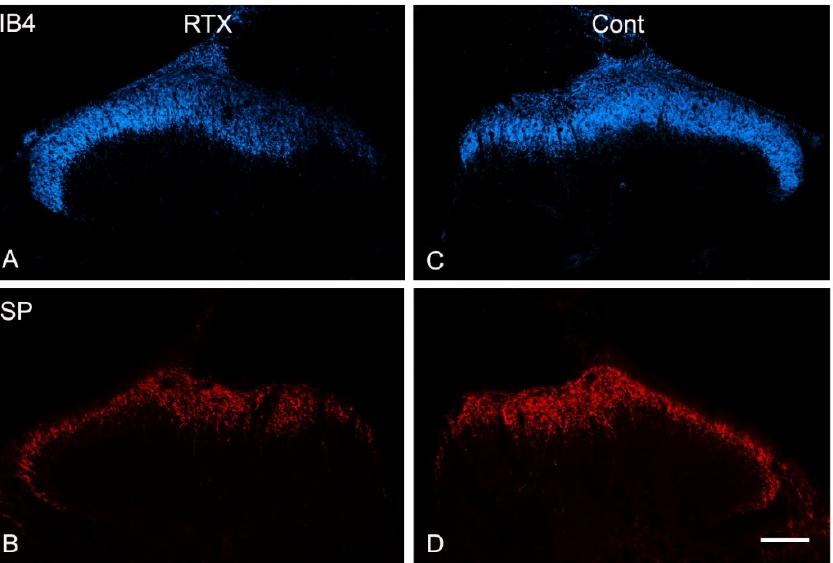
RTX treatment produced a marked downregulation of TRPV1-( A ), CGRP-( B ) and upregulation of VIP-immunoreactivity ( C ) in the same medial aspect of the superficial laminae of the spinal cord ipsilaterally (between two white arrows). No clear changes were observed in the contralateral (cont) side of the dorsal horn of the spinal cord ( E – H ). D and H are merged images. Scale bar = 100 µm.